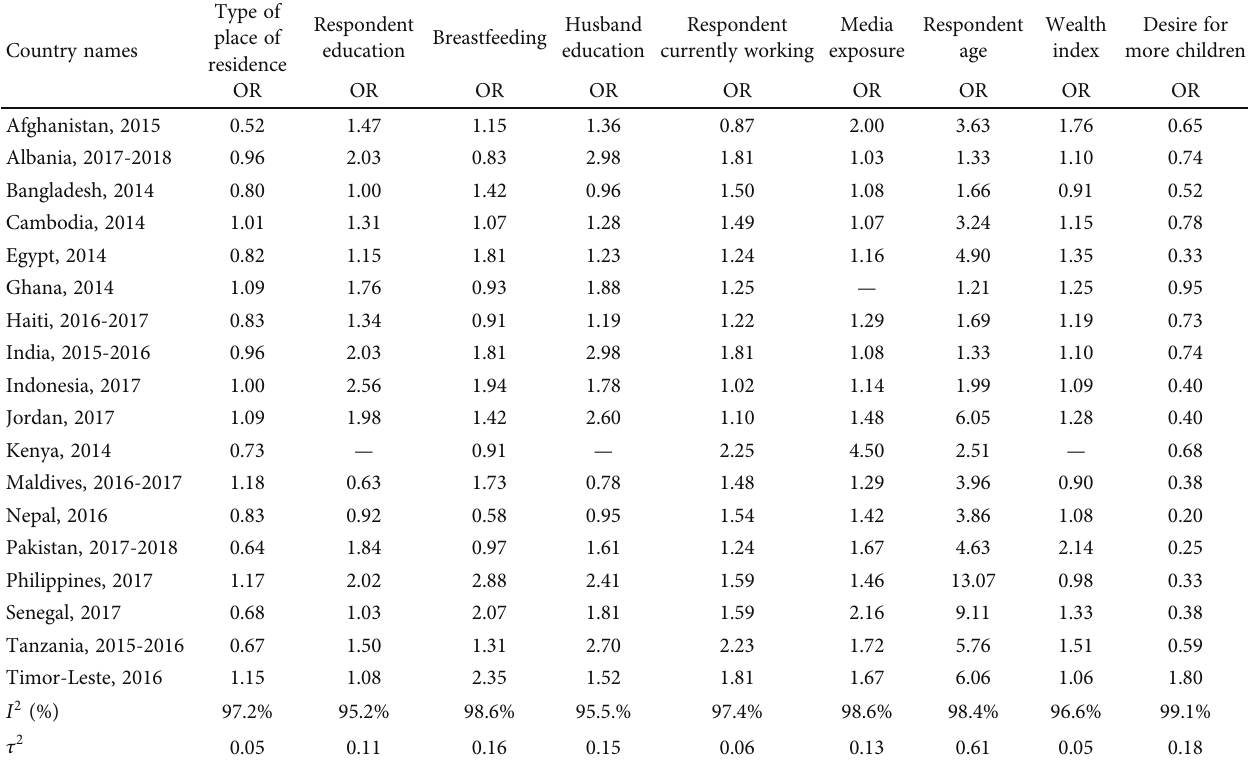
Table 3: Random e ff ects model estimation of OR for 18 developing